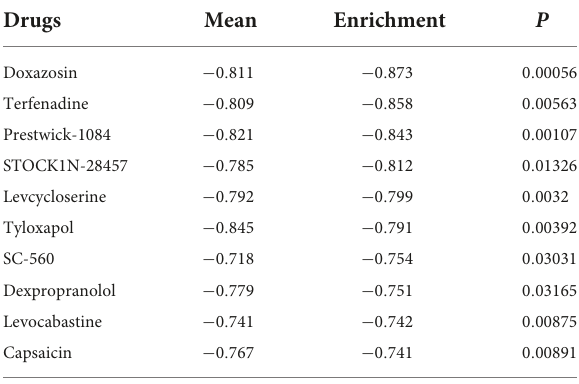
TABLE 7 The top 10 small molecule drug screening based on CMap (the smallest enrichment score). Drugs